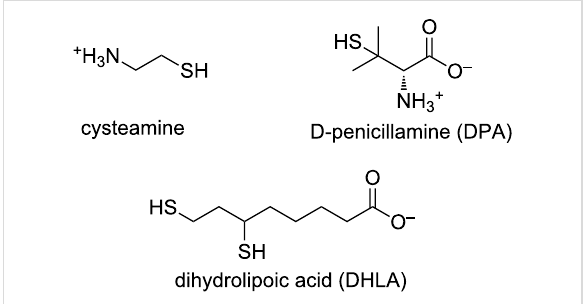
Figure 5: NP surface ligands employed in the present study. They as- sociate with the CdSe/ZnS QD surface via their thiol